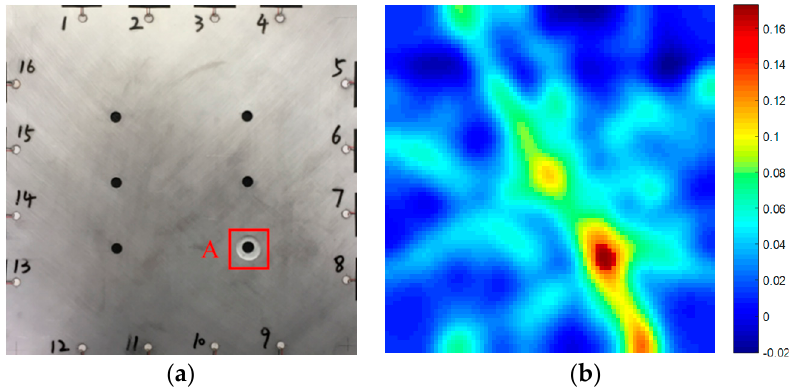
Figure 12. ( a ) The area of real one hole corrosion damage and ( b ) the area of predicted one hole corrosion damage. Table 3. Damage simulation and prediction results.